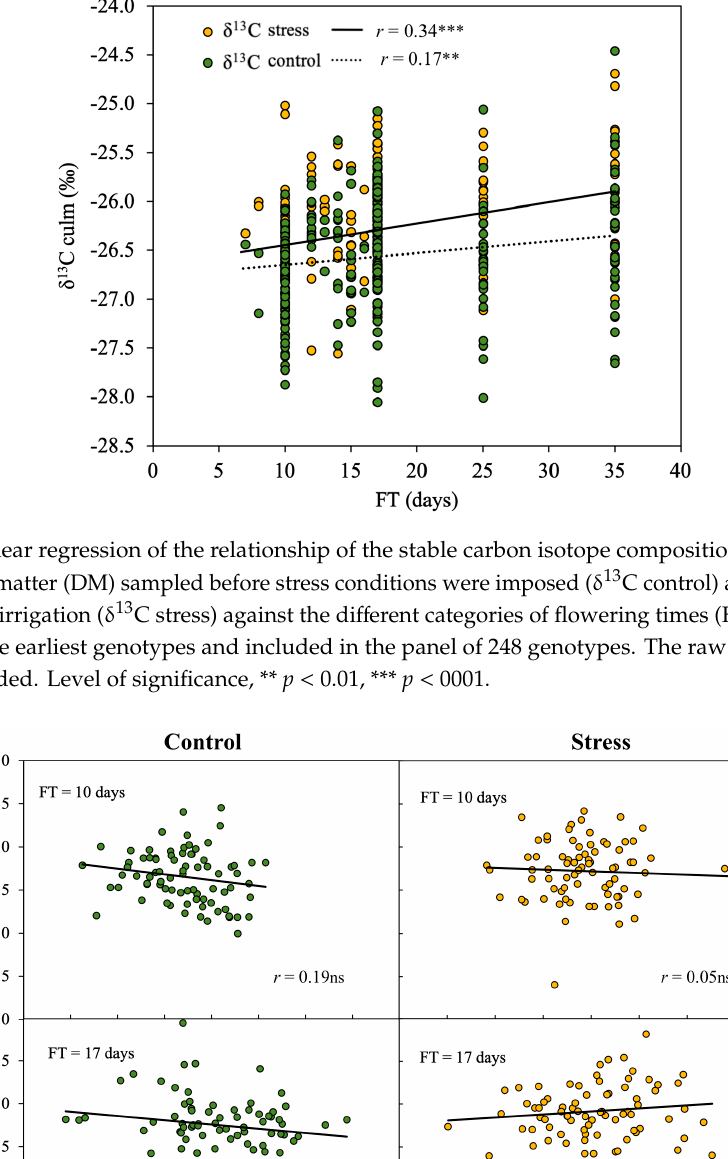
Figure 5. Linear regression of the relationship between the plant biomass at mid grain filling and the stable carbon isotope composition ( δ 13 C) in the flag leaf dry matter sampled before stress conditions were imposed ( δ 13 C control, right panels) and two weeks after the last irrigation ( δ 13 C stress, left panels) across the subset of genotypes exhibiting the same date of anthesis: 10 days after the earliest